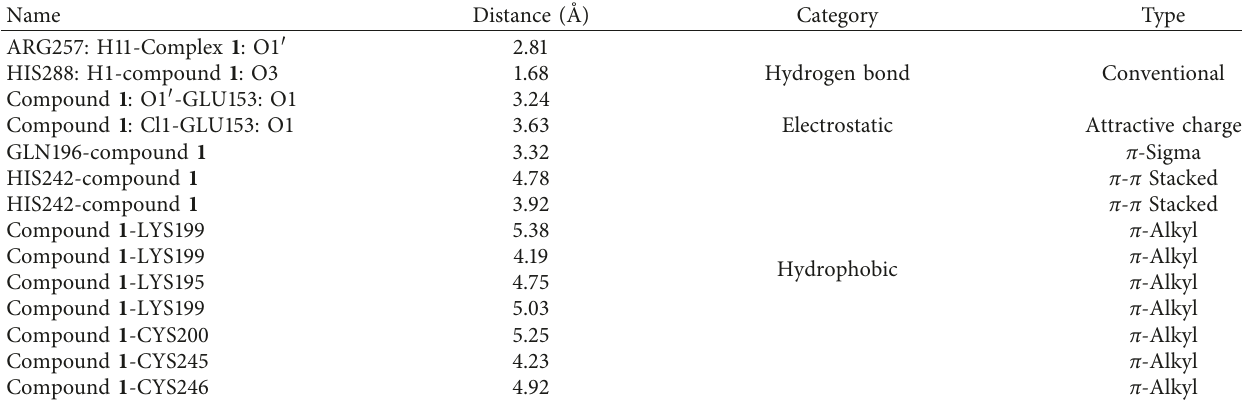
Figure 10: Noncovalent interactions of compounds (a) 1 and (b) 2 at the subdomains IIA and IB of HSA, respectively. Table 4: Noncovalent interactions of compound 1 with the HSA binding site IIA.